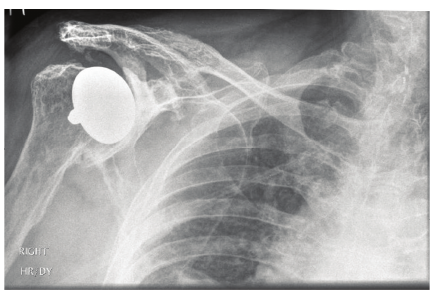
Figure 3: AP radiograph of the right shoulder taken 4 years postoperatively.